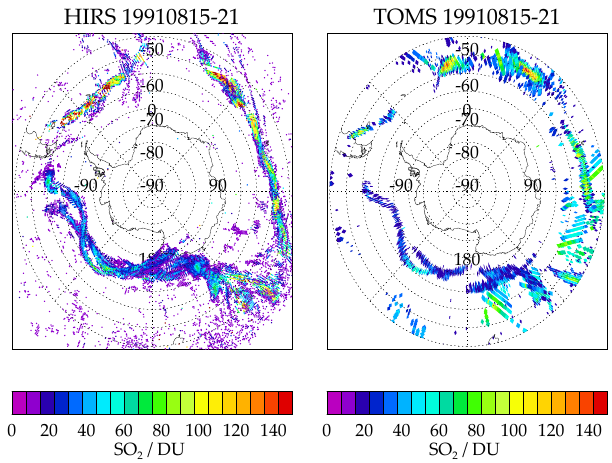
Figure 9. Seven-day composite of retrieved SO 2 from 15 to 21 Au- gust 1991. For clarity in comparison, TOMS data are screened to have a minimum value of 15DU, and HIRS/2 data use 3 σ (7.1DU).